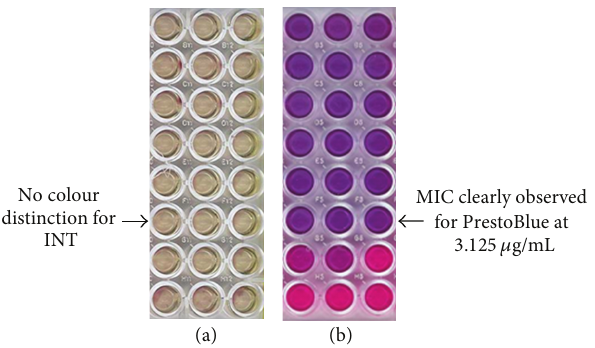
Figure 2: Comparison of different growth indicators on P. acnes : (a) INT and (b) PrestoBlue on P. acnes